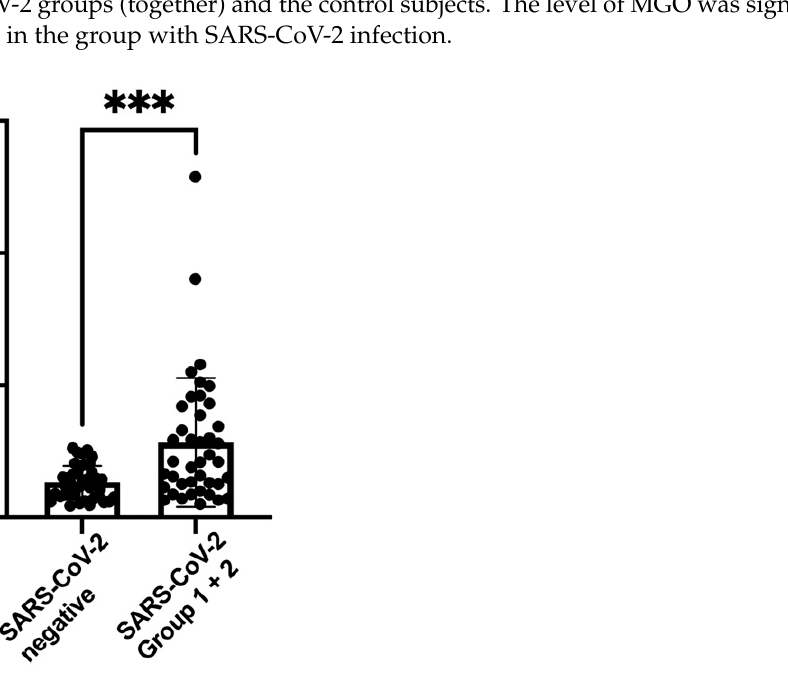
Figure 1. Scatterplot of glycated albumin (GA) percentages (medians and interquartile ranges) of SARS-CoV-2 groups 1 and 2 (2.1; IQR 1.2–4.04) versus the SARS-CoV-2-negative controls (1.31; IQR 0.79–1.7). *** p -value < 0.001.